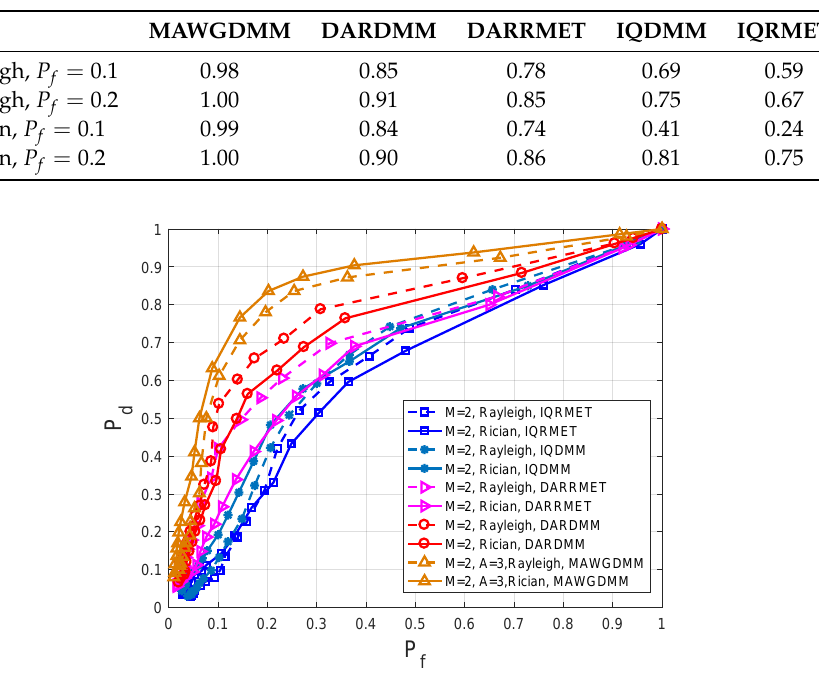
Figure 8. Comparison of ROC in different methods at SNR = − 16 dB. Table 3. Detection probabilities of different algorithms when the SNR = − 16